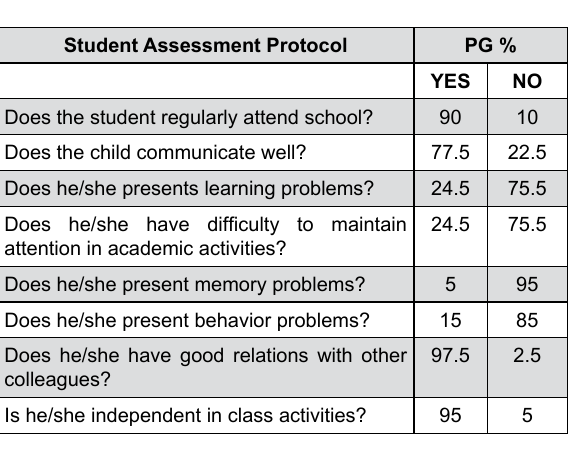
Figure 3- Results of the Student Assessment Protocol of the PG and